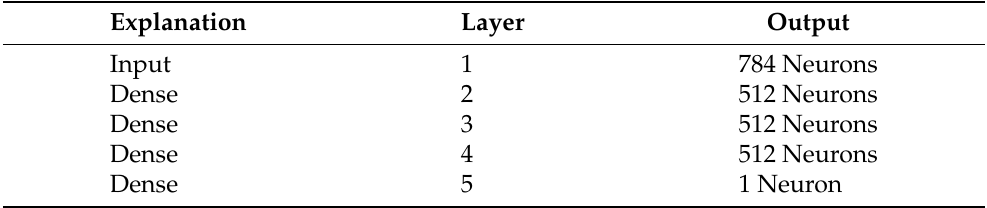
Table A2. The architecture of the discriminator used for the fmnist-based datasets.